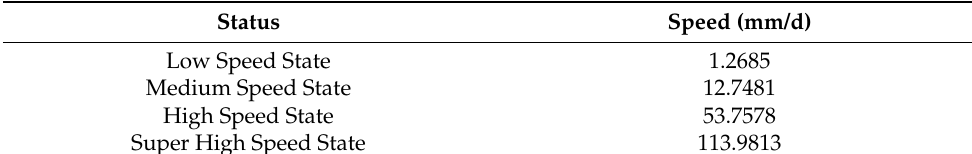
Table 1. Clustering centroids of the Zhongma landslide.